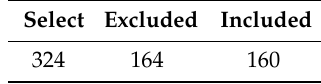
Table 4. Papers concerning empirical research.